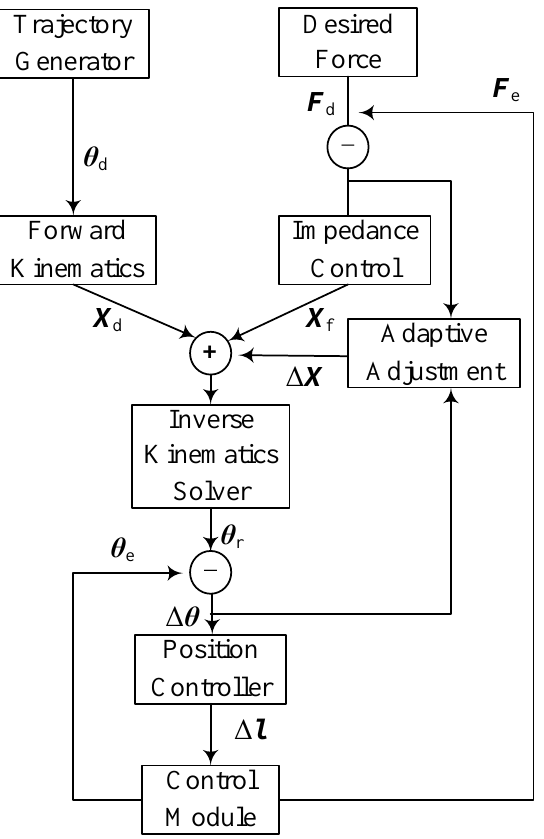
Figure 4. The components of the control system.